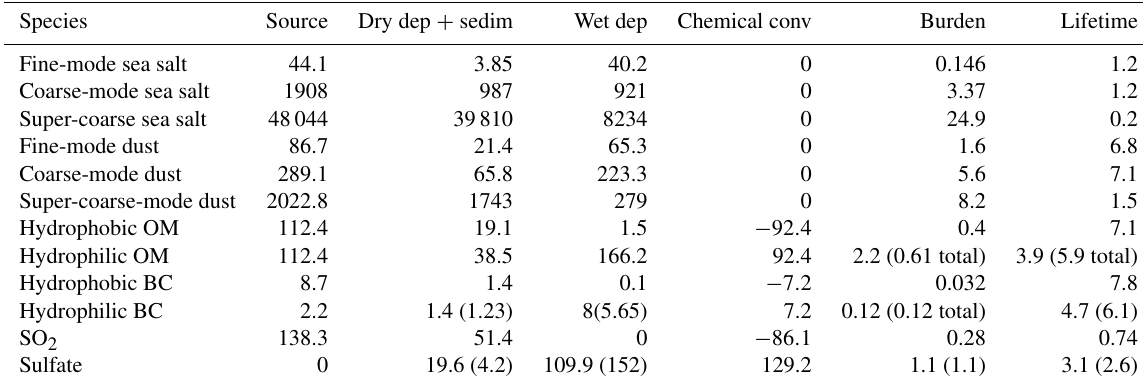
Table 12. IFS-AER budgets for the June 2016 to May 2018 period (fluxes: Tgyr − 1 , burdens: Tg, lifetimes: days). Equivalents for GEOS- Chem from Croft et al. (2014) when available and comparable are indicated in